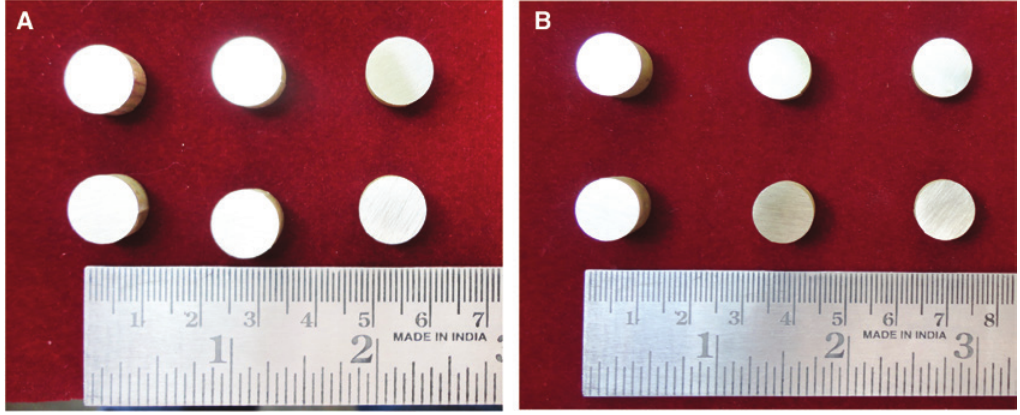
Figure 3: Erosion corrosion samples.